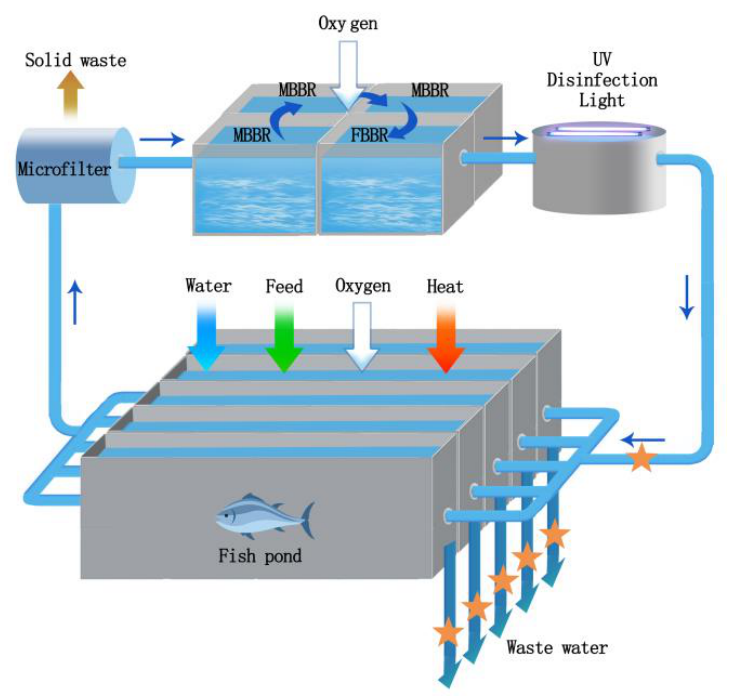
Figure 1. Schematic diagram of the RAS used in this study. Sampling locations are marked with stars.